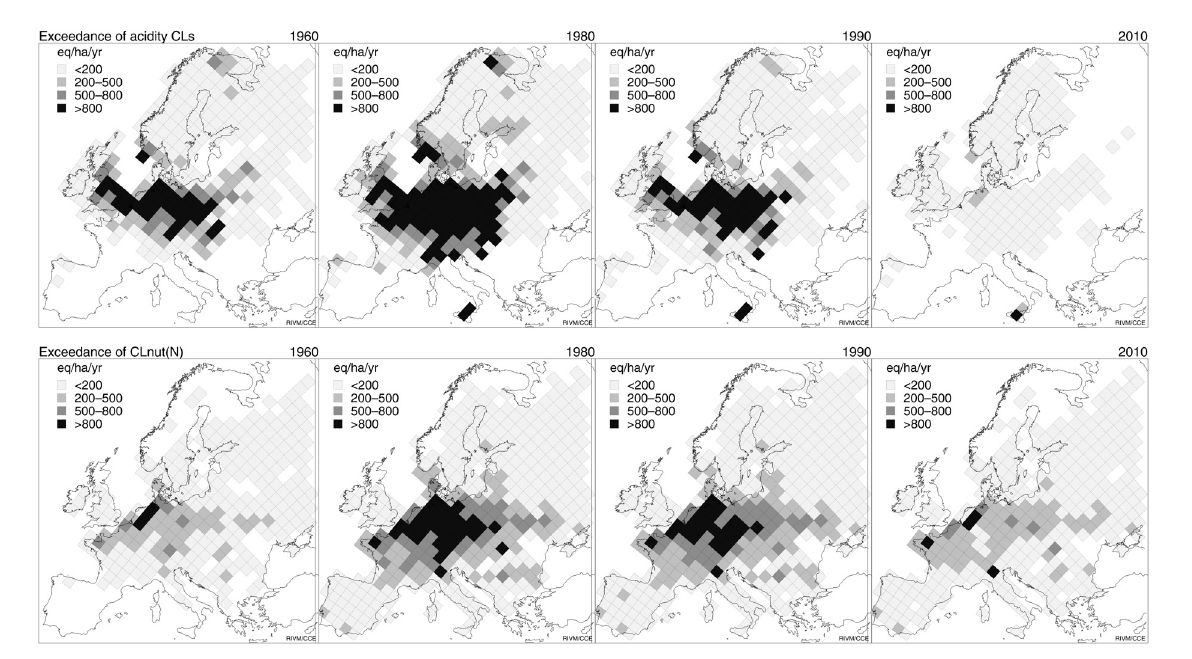
FIGURE 3. Temporal development (1960–2010) of the average accumulated exceedance (AAE) of acidity critical loads (top row) and critical loads of nutrient nitrogen (bottom). White areas indicate nonexceedance (or lack of